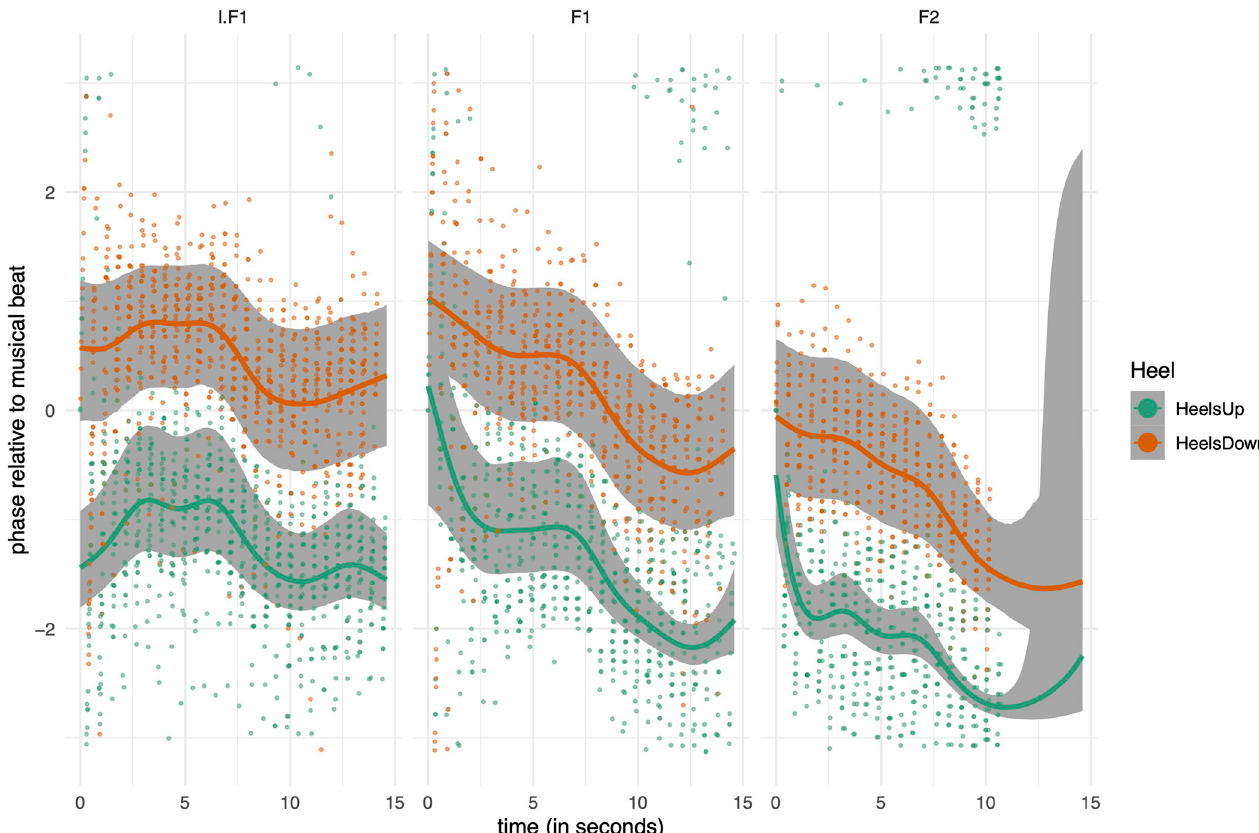
Fig 6. Results of model H2a. Dynamic means (full lines) and 95% critical intervals (bands) of posterior predictions overlayed with the raw data (small dots). Horizontal axis is performance time, vertical axis is phase (in radians).